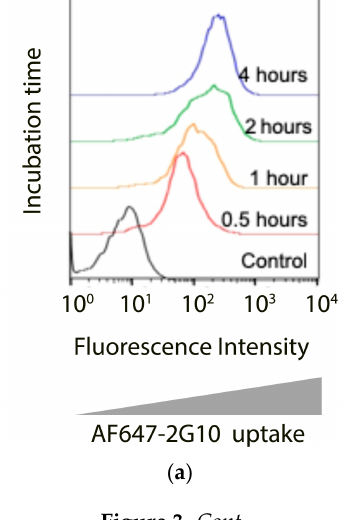
Table 1. Antibody-drug conjugate (ADC)